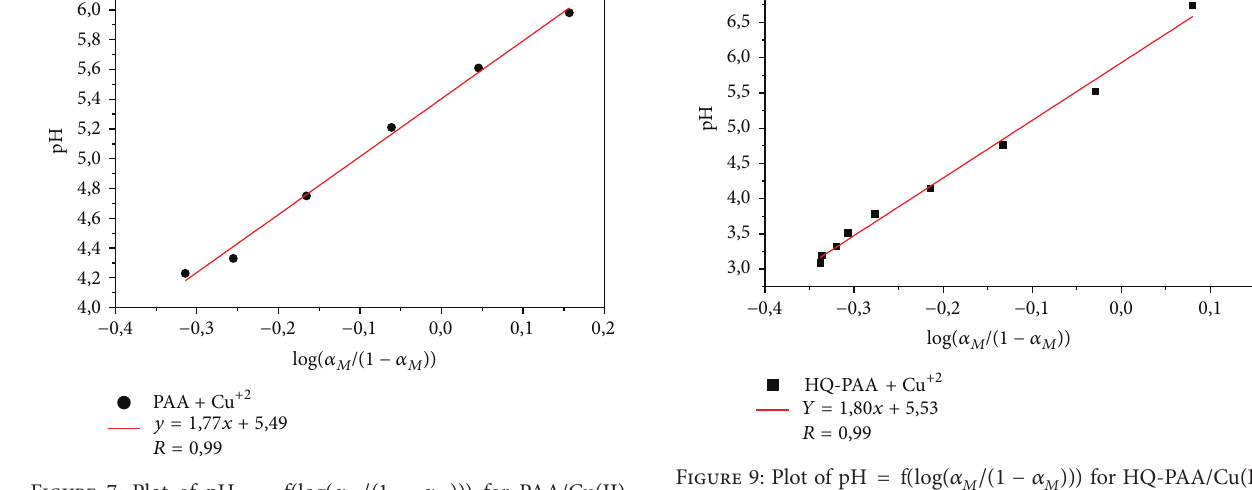
Figure 7: Plot of pH = f ( log (𝛼 𝑀 /(1 − 𝛼 𝑀 ))) for PAA/Cu(II). [NaNO 3 ] = 0.00mol/L.